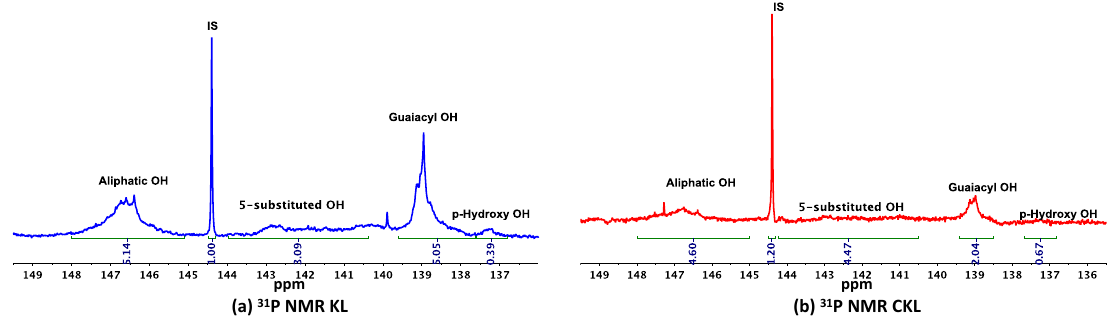
Figure 3. Functional group analysis of lignin by quantitative 31 P-NMR measurements after phosphitylation; ( a ) Kraft Lignin (KL); ( b ) capped Kraft lignin (CKL) with dimethyl carbonate (DMC). IS = internal standard. Table 1. Hydroxyl content quantification by 31 P-NMR spectroscopy of KL and CKL. OH OH (mmol/g) Aliphatic OH Lignin